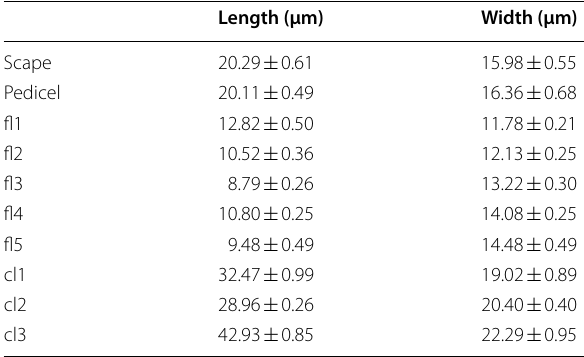
Table 1 Mean (SE) of the length (μm) and basal width (μm) ± of the scape, pedicel and all flagellomeres of the funicle (fl1–fl5) and club (cl1–cl3) of the antenna of adult Rhyzopertha